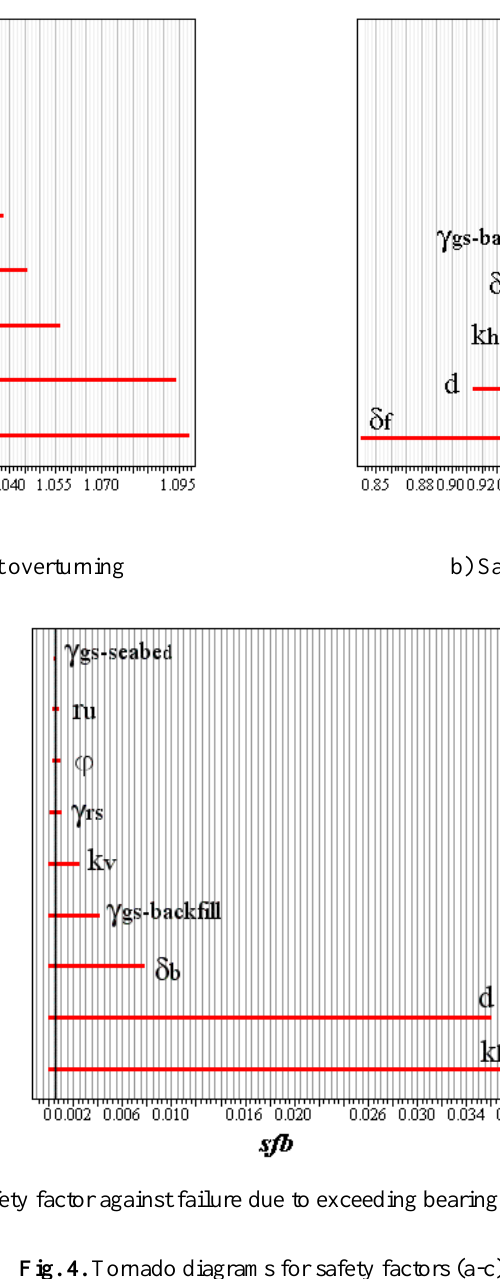
Fig. 4. Tornado diagrams for safety factors